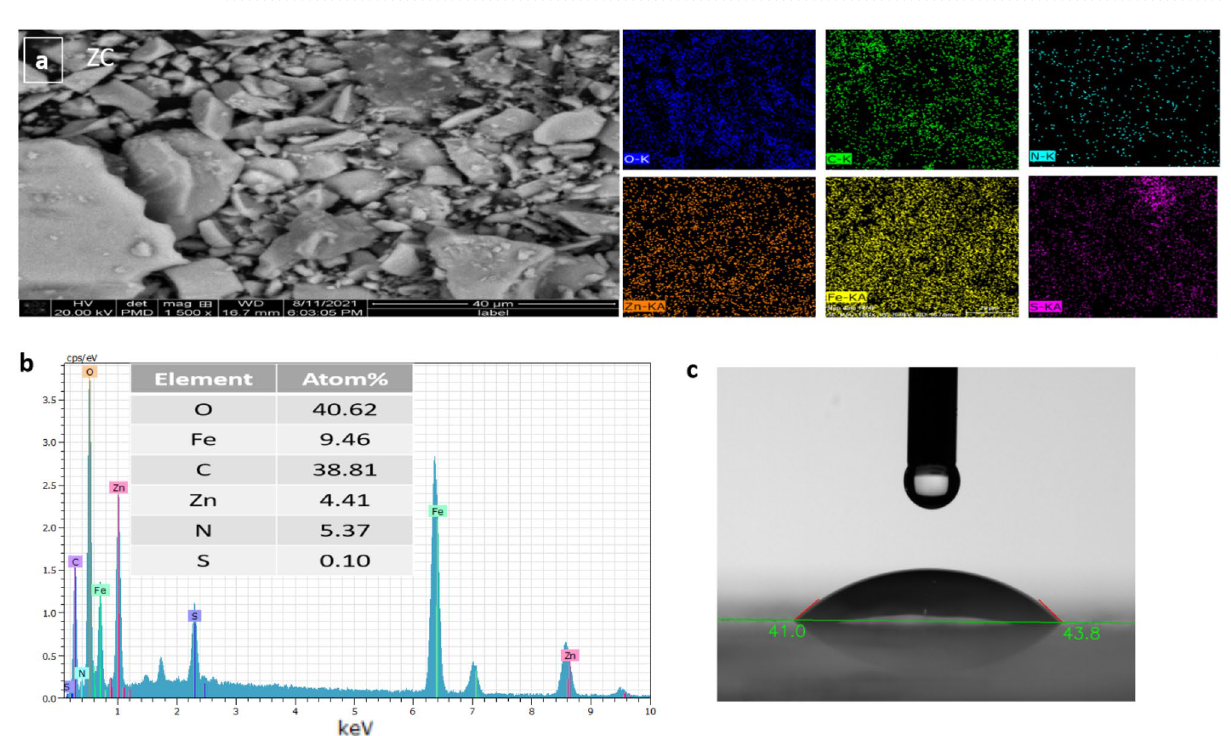
Figure 4. ( a ) Elemental mapping, ( b ) EDS analysis of ZC, and ( c ) contact angel image of